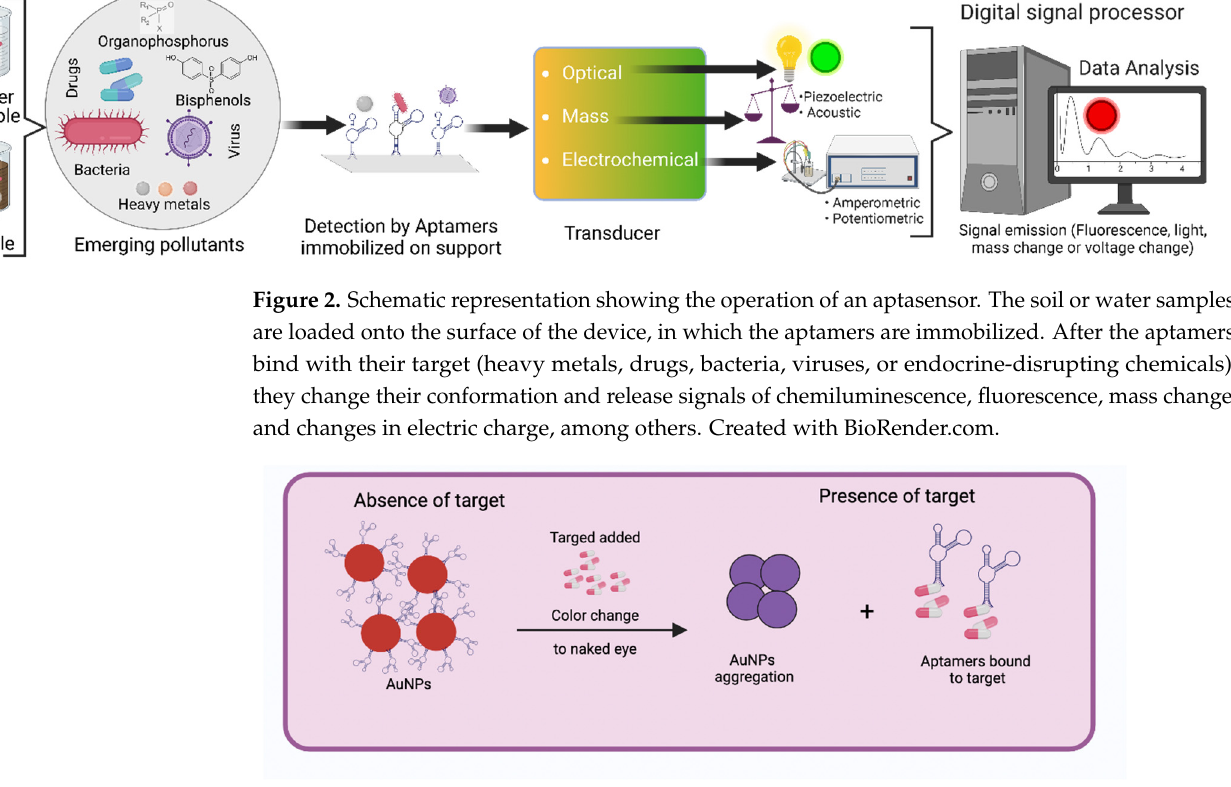
Figure 3. Schematic illustration showing the operation of the colorimetric aptasensor in the absence and presence of its target. In the absence of the target, the aptamers are anchored to the surface of the gold nanoparticles (AuNPs). However, a color change from red to purple is observed with the naked eye when the target is presented, which is caused by the aggregation of the AuNPs after the detachment of the aptamers from the surface of the nanoparticles to be able to bind with their target. Created with BioRender.com.